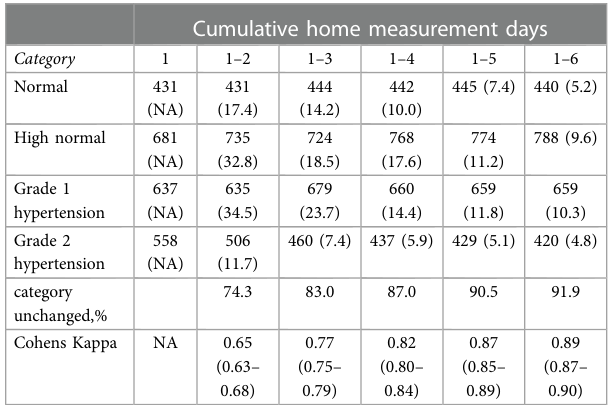
TABLE 2 Cumulative mean of consecutive measurement days for BP- classi fi